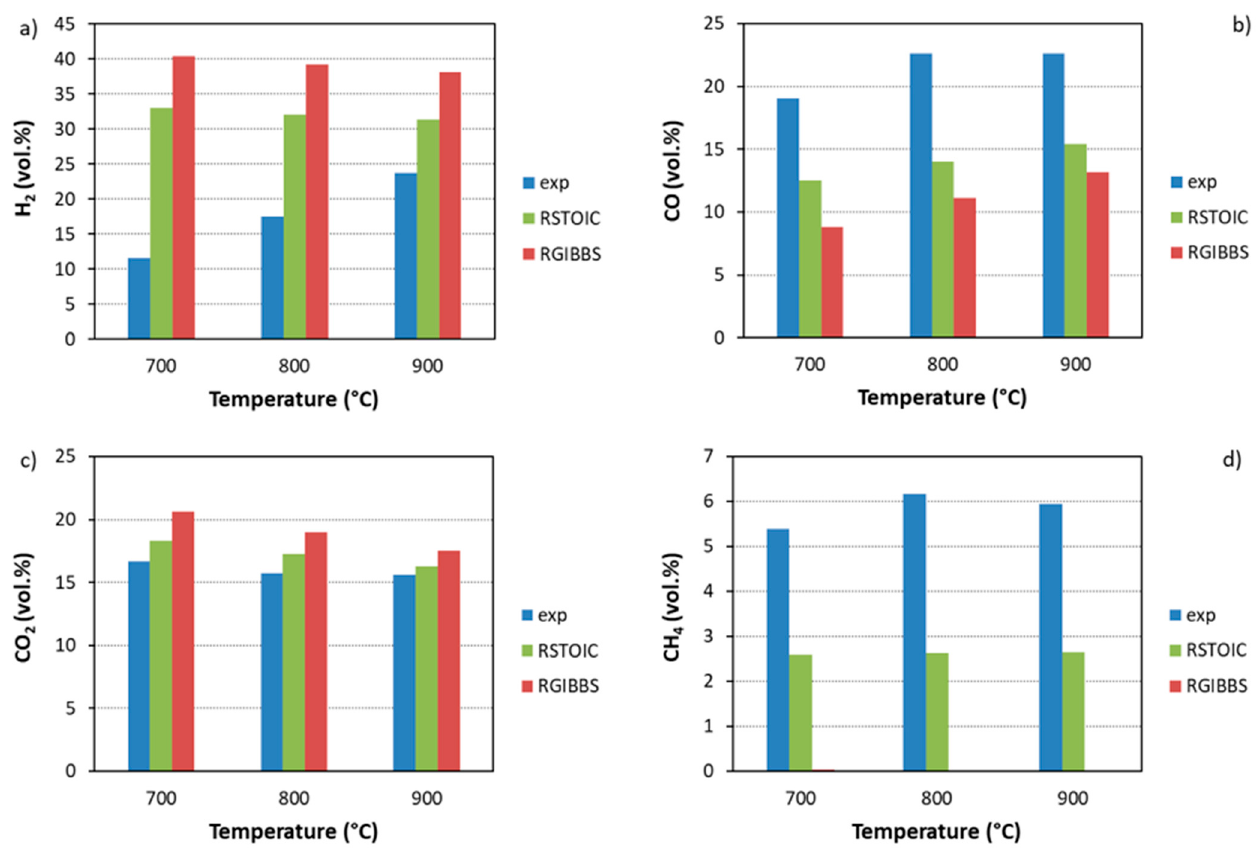
Figure 7. Comparison between the gas concentrations at different temperatures during the gasification of PKS using 70 vol.% steam with SR = 0.2 and the predictions obtained with stoichiometric and non-stoichiometric models: ( a ) H 2 , ( b ) CO, ( c ) CO 2 and ( d ) CH 4 (CH 4 values of RGIBBS model are negligible).